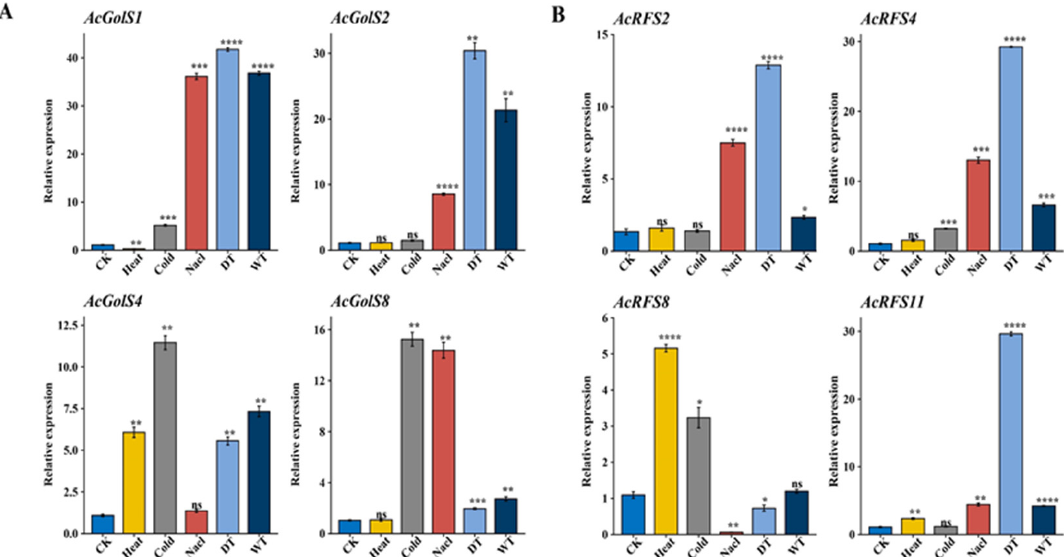
Figure 7. Expression levels of key AcGolS and AcRFS genes under abiotic stresses (heat, cold, salt, drought, waterlogging) by quantitative real-time RT-PCR. ( A ) Expression levels of AcGloS1/2/4/8 . ( B ) Expression levels of AcRFS2/4/8/11 . Three biological and technical replicates calculated the error bars. Asterisks indicated the corresponding gene significantly up or down-regulated under the different treatments using t -test (* p < 0.05, ** p < 0.01, *** p < 0.001, **** p < 0.0001; one-way ANOVA test by Tukey’s test). Ns indicated the corresponding gene no significantly up or down-regulated under the different treatments using t -test.